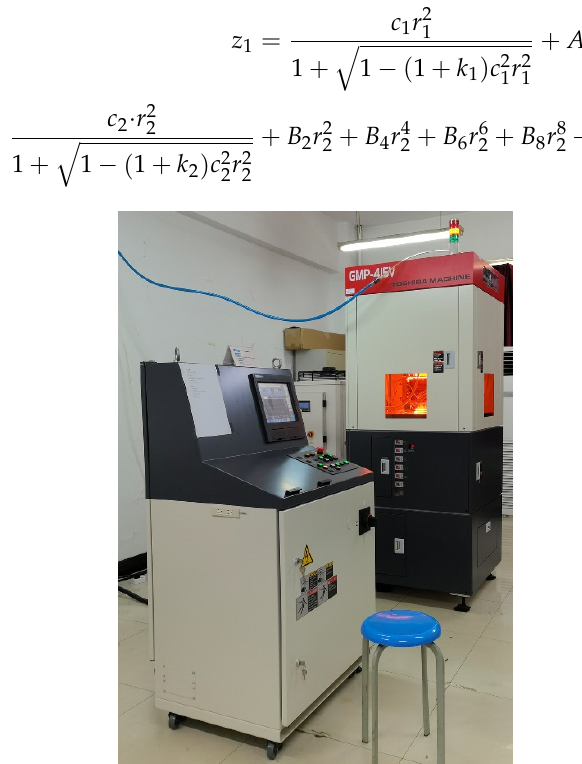
Figure 1. The photograph of the precision glass mold press machine (Model GMP-415V) from Toshiba Machine Co., Ltd.